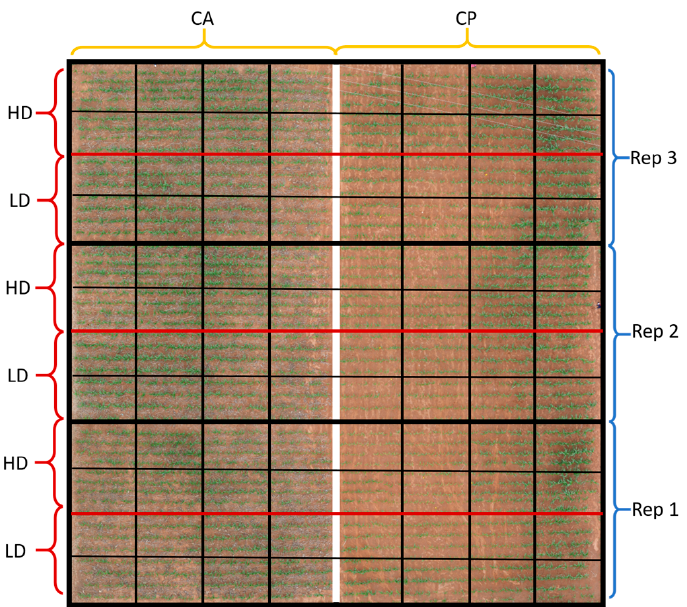
Figure 2. Map of the experimental design showing alternating High Density (HD) and Low Density (LD) plots per replicate, with Conservation Agriculture (CA) on the left and Conventional Ploughing (CP) on the right. Each square corresponds one plot dedicated to each of the different hybrids used. Complete details of the experimental design are explained in Section 2.2.